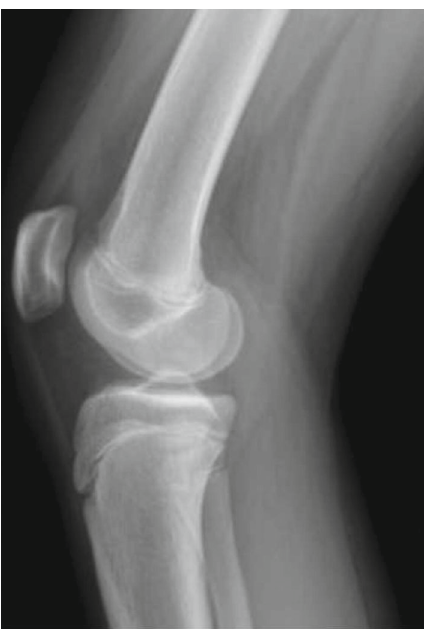
Figure 1: Preoperative lateral view radiograph of the right knee demonstrating open growth plates.